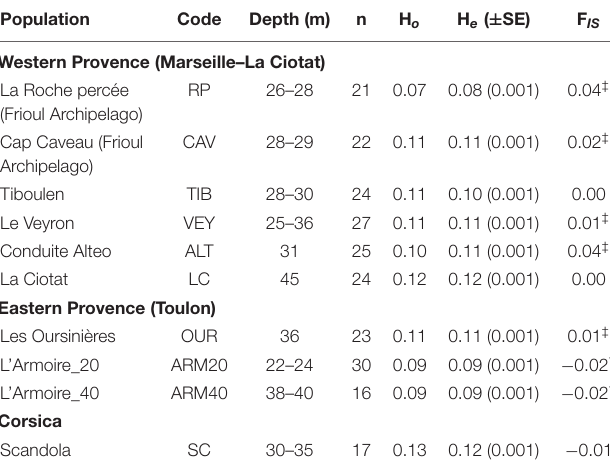
TABLE 1 | Genetic diversity within populations of Ericaria zosteroides based on 10,755 neutral SNPs (n, number of individuals successfully genotyped; H o , observed heterozygosity; H e , expected heterozygosity and SE among loci; F IS , average inbreeding